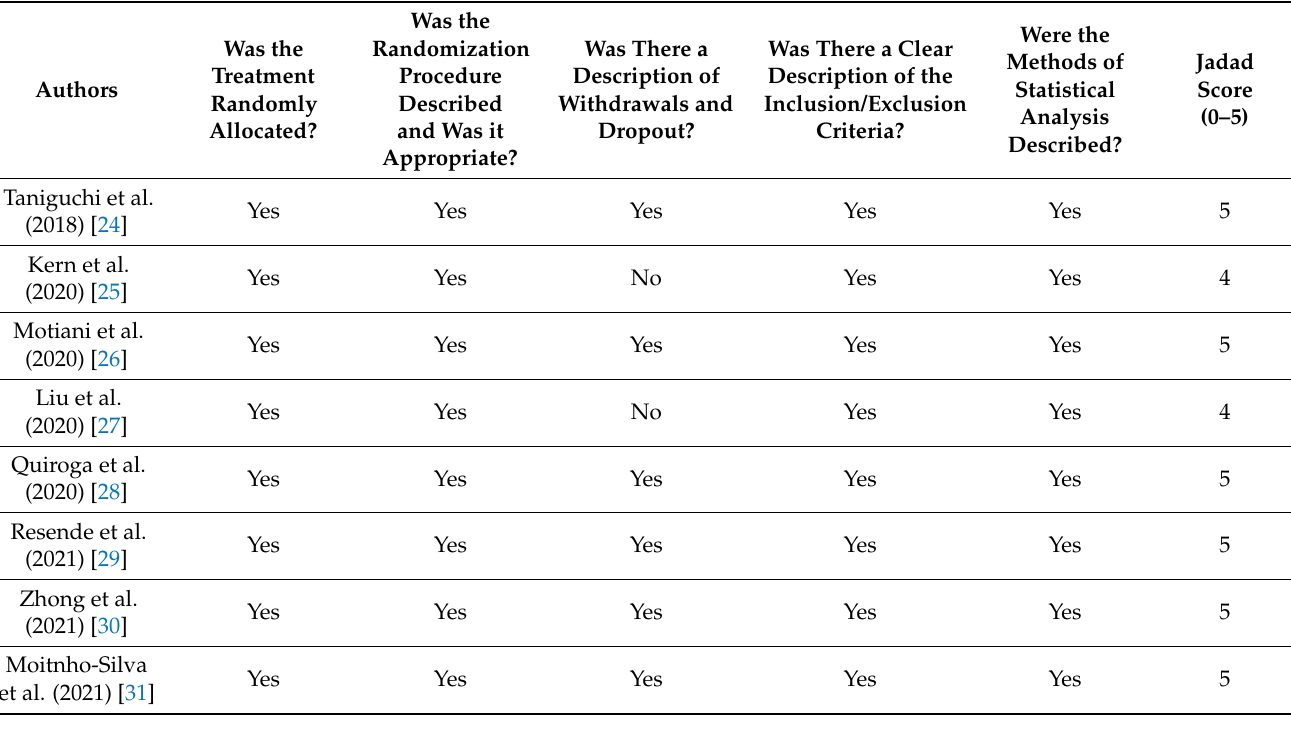
Table 2. The modified Oxford quality scale.